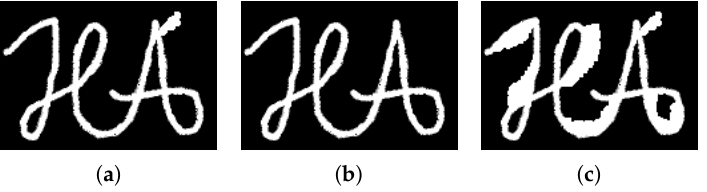
Figure 2. Three images with the same Hausdorff distances but different topology; ( a ) compared image 1; ( b ) reference image; ( c ) compared image